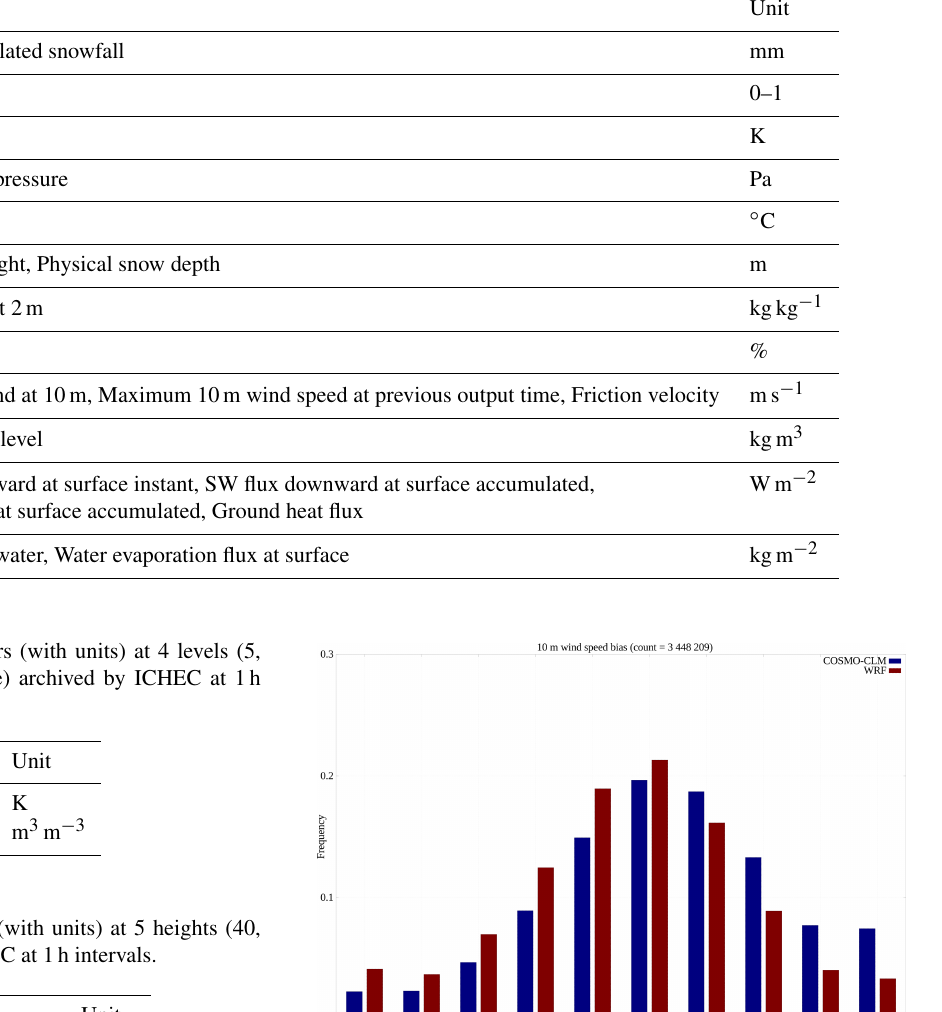
Table 6. WRF surface or near-surface parameters (with units) archived by ICHEC at 1h intervals. Variable Unit Total precipitation, Accumulated snowfall